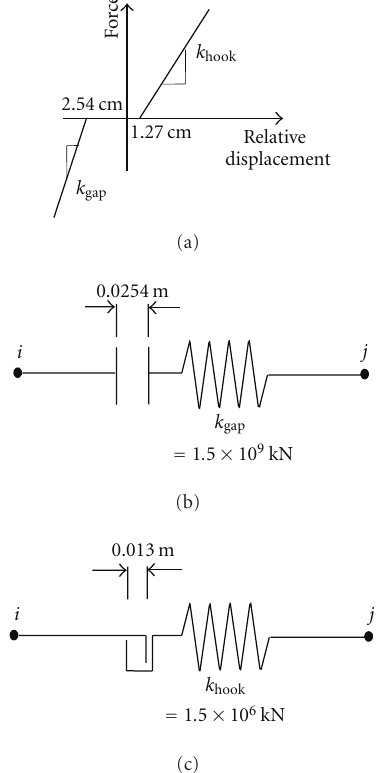
Figure 6: Nonlinear modeling of (a) expansion joint, (b) gap el- ement for pounding at expansion joint, and (c) hook element for restrainer at expansion